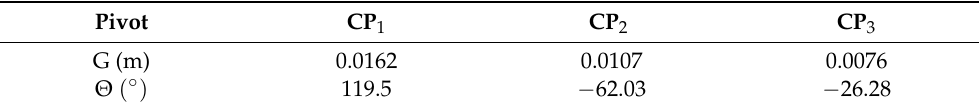
Table 1. Optimal design variables of PC2.